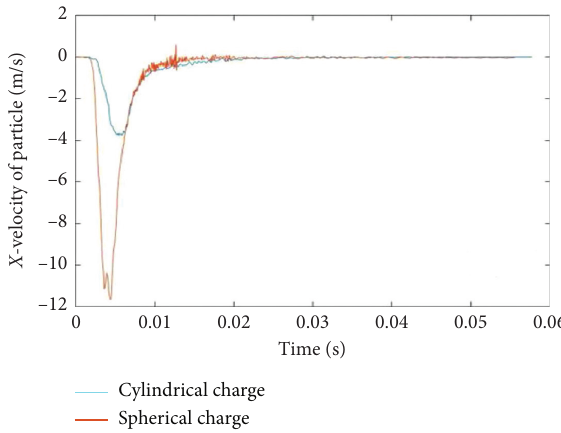
Figure 11: X -direction velocity-time curve of rock particle. Table 3: Main blasting effect parameter by numerical simulation.